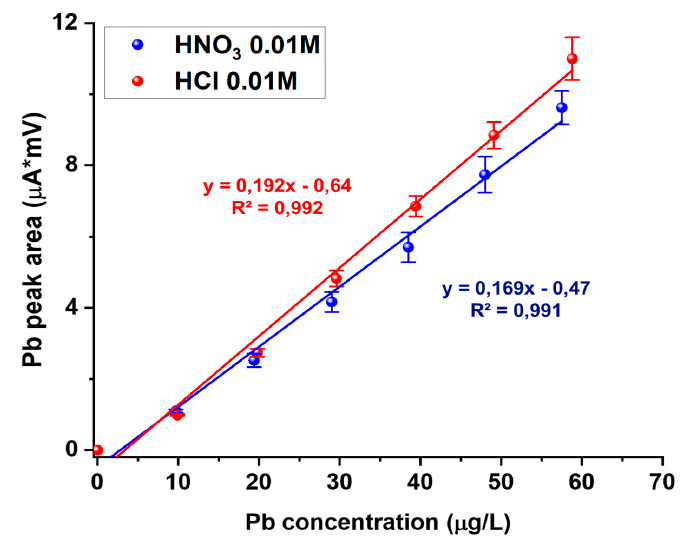
Figure 4. Comparison between calibration lines for Pb analysis in 0.01 M HCl (red line) and 0.01 M HNO 3 (blue line) on a working Bi/PO 4 /PSS electrode.